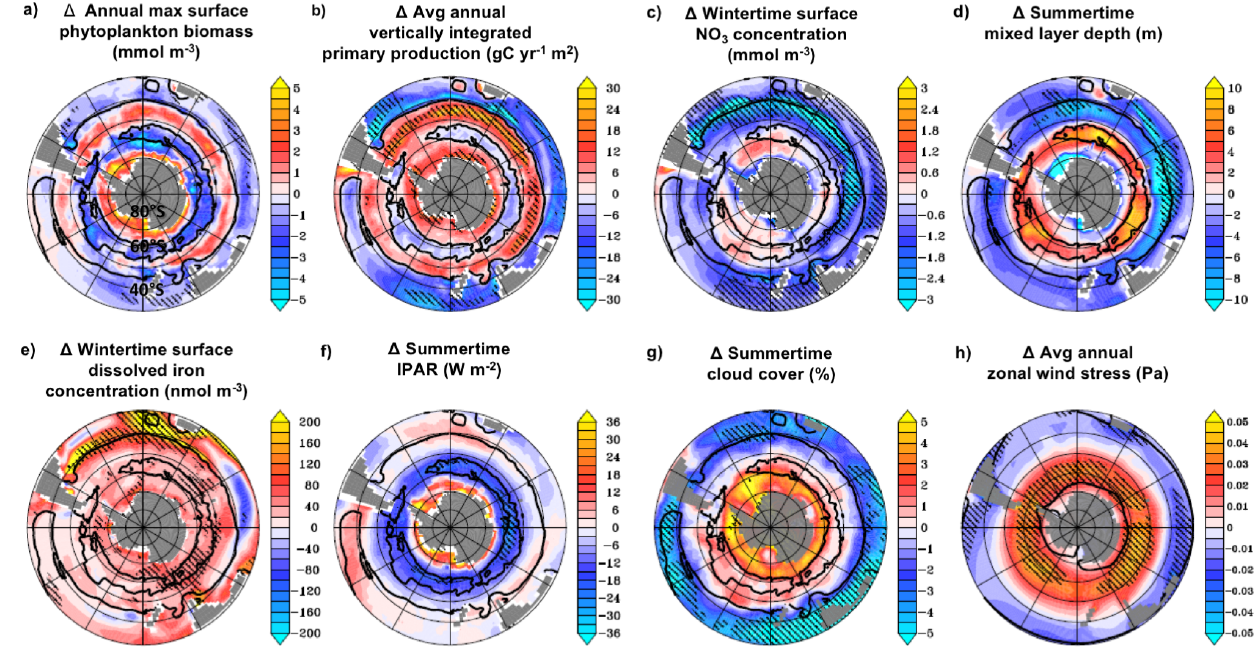
Figure 1. All-model mean 100-year changes. 100-year all-model mean changes in (a) maximum annual surface phytoplankton biomass (PB), (b) average annual 100m depth vertically integrated primary production (PP), (c) wintertime surface nitrate concentration, (d) summertime mixed layer depth (MLD), (e) wintertime surface dissolved iron concentration, (f) summertime incident photosynthetically available radiation (IPAR), (g) summertime percentage area of grid cell covered by clouds, and (h) average annual zonal wind stress. Hatched areas are where greater than 80% of model realizations agree on the sign of the change using a bootstrap significance test (see Sect. 2.2 for methodological details). Zero contours for PP change are plotted over each map. The number of models ( n ) and the total model weight ( w ) taken into account for each variable are listed in Fig. 5. Historical all-model mean maps are presented in Figs.